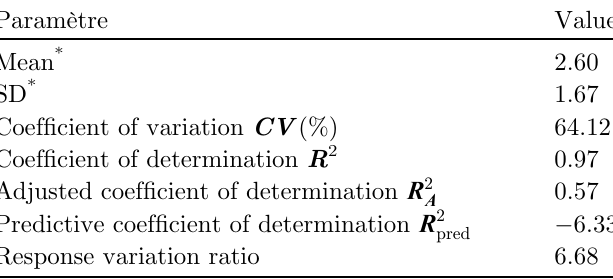
Table 7. Descriptive and predictive qualities of polynomial